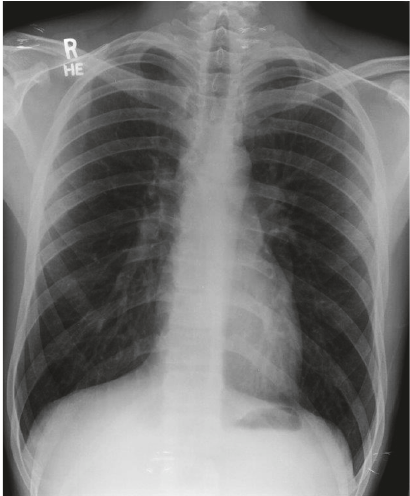
Figure 3: Chest X-ray of patient repeated 1 year later showing complete resolution of the cystic lesions.